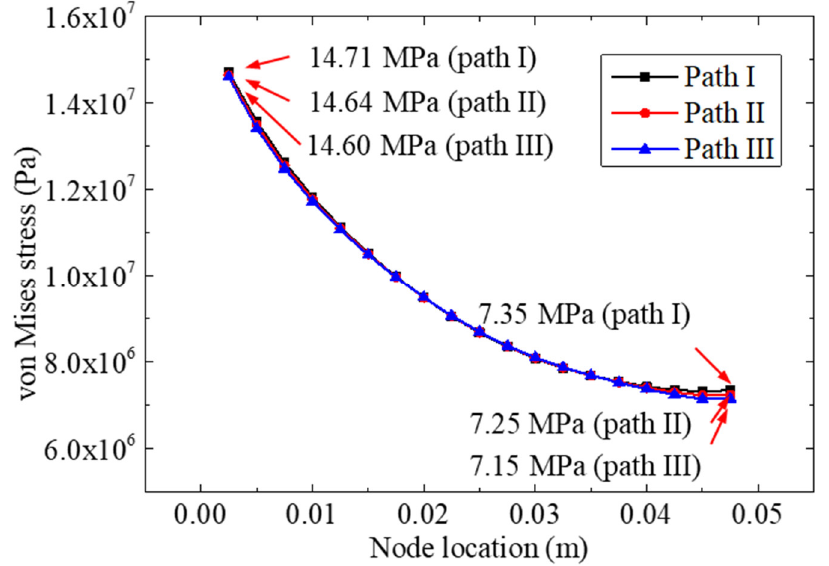
Figure 7. The von Mises stresses of nodes on path II.